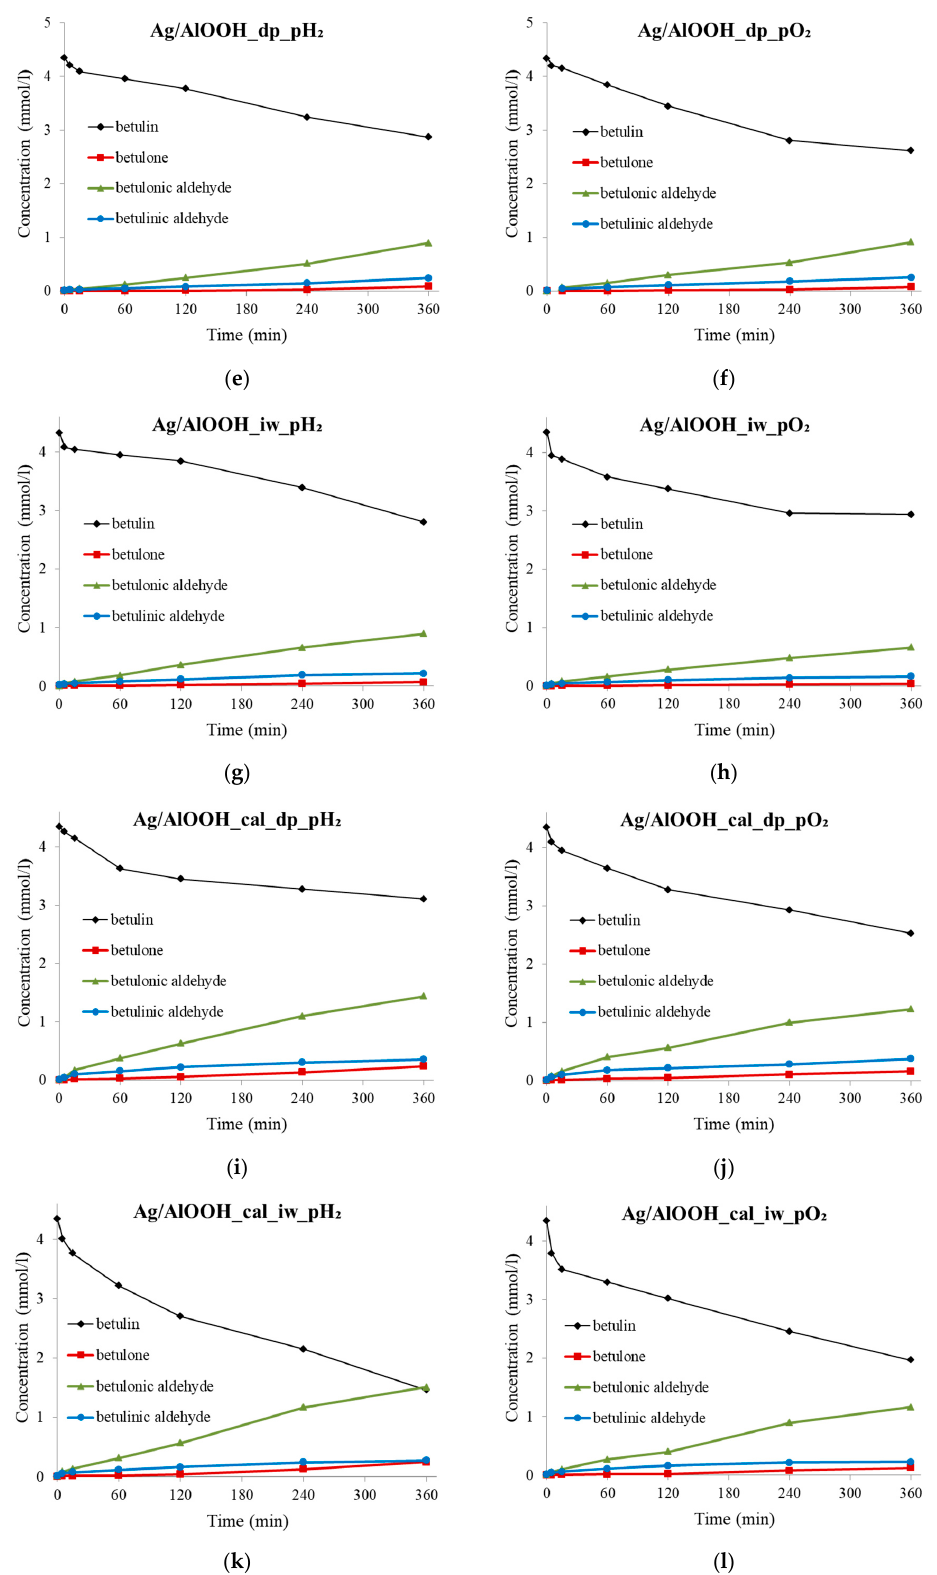
Figure 3. Kinetics of betulin oxidation over different silver catalysts, data are presented taking into account the mass balance closure: ( a ) Ag/ γ -Al 2 O 3 _dp_pH 2 ; ( b ) Ag/ γ -Al 2 O 3 _dp_pO 2 ; ( c ) Ag/ γ -Al 2 O 3 _iw_pH 2 ; ( d ) Ag/ γ -Al 2 O 3 _iw_pO 2 ; ( e ) Ag/AlOOH_dp_pH 2 ; ( f ) Ag/AlOOH_dp_pO 2 ; ( g ) Ag/AlOOH_iw_pH 2 ; ( h ) Ag/AlOOH_iw_pO 2 ; ( i ) Ag/AlOOH_cal_dp_pH 2 ; ( j ) Ag/AlOOH_cal_dp_pO 2 ; ( k ) Ag/AlOOH_cal_iw_pH 2 ; ( l ) Ag/AlOOH_cal_iw_pO 2 ; conditions: 140 ◦ C, synthetic air (50 mL/min) as oxidant, solvent-mesitylene, initial betulin concentration: 4.5 mmol/L, 0.2 g